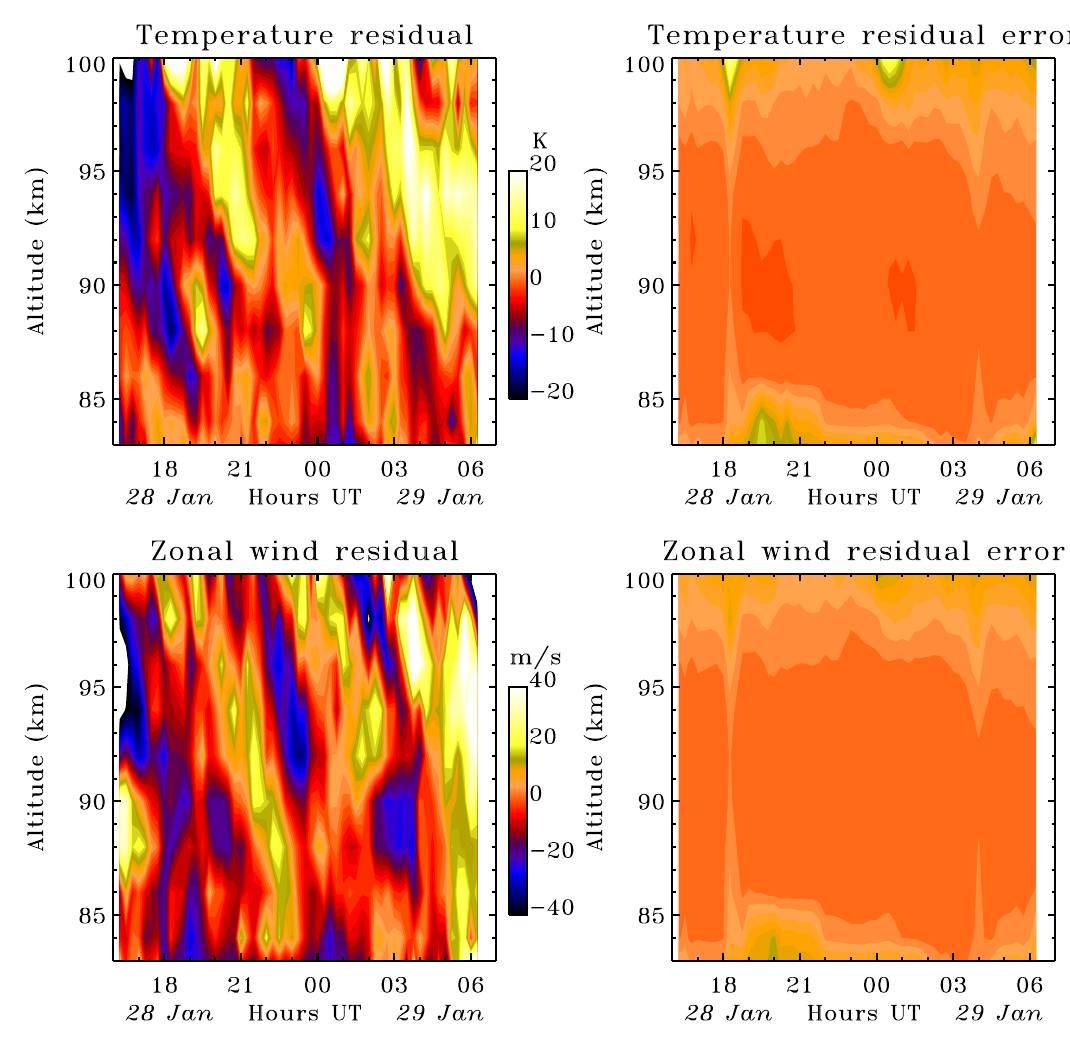
Fig. 5. Contour plots of the residual wind and temperature fields after subtracting the semidiurnal fit. Note the many perturbations larger than the errors (shown on the right) with mostly downward phase